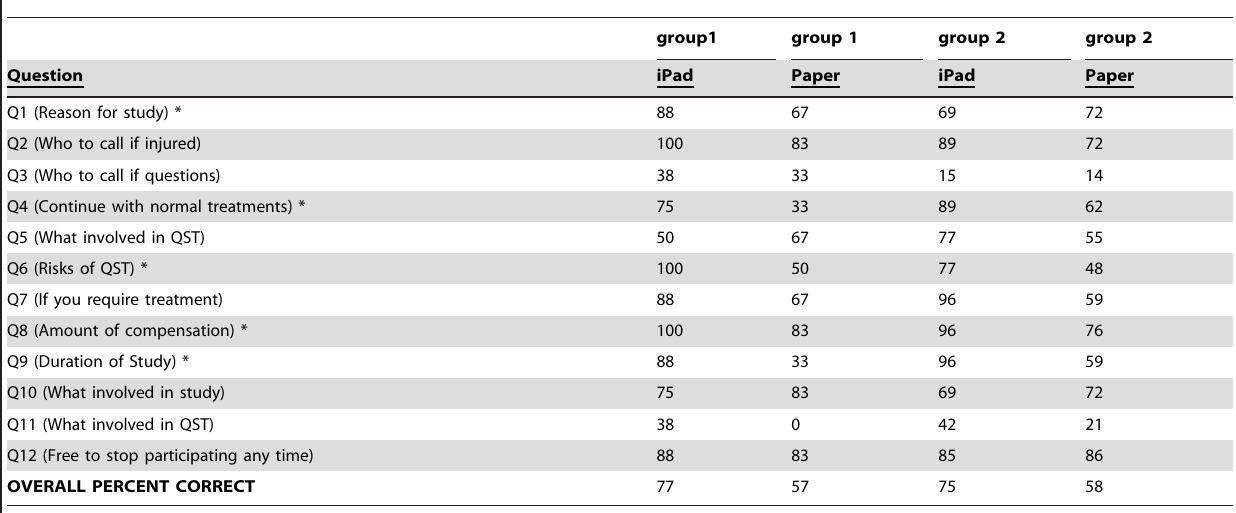
Table 1. Post-review online survey test question